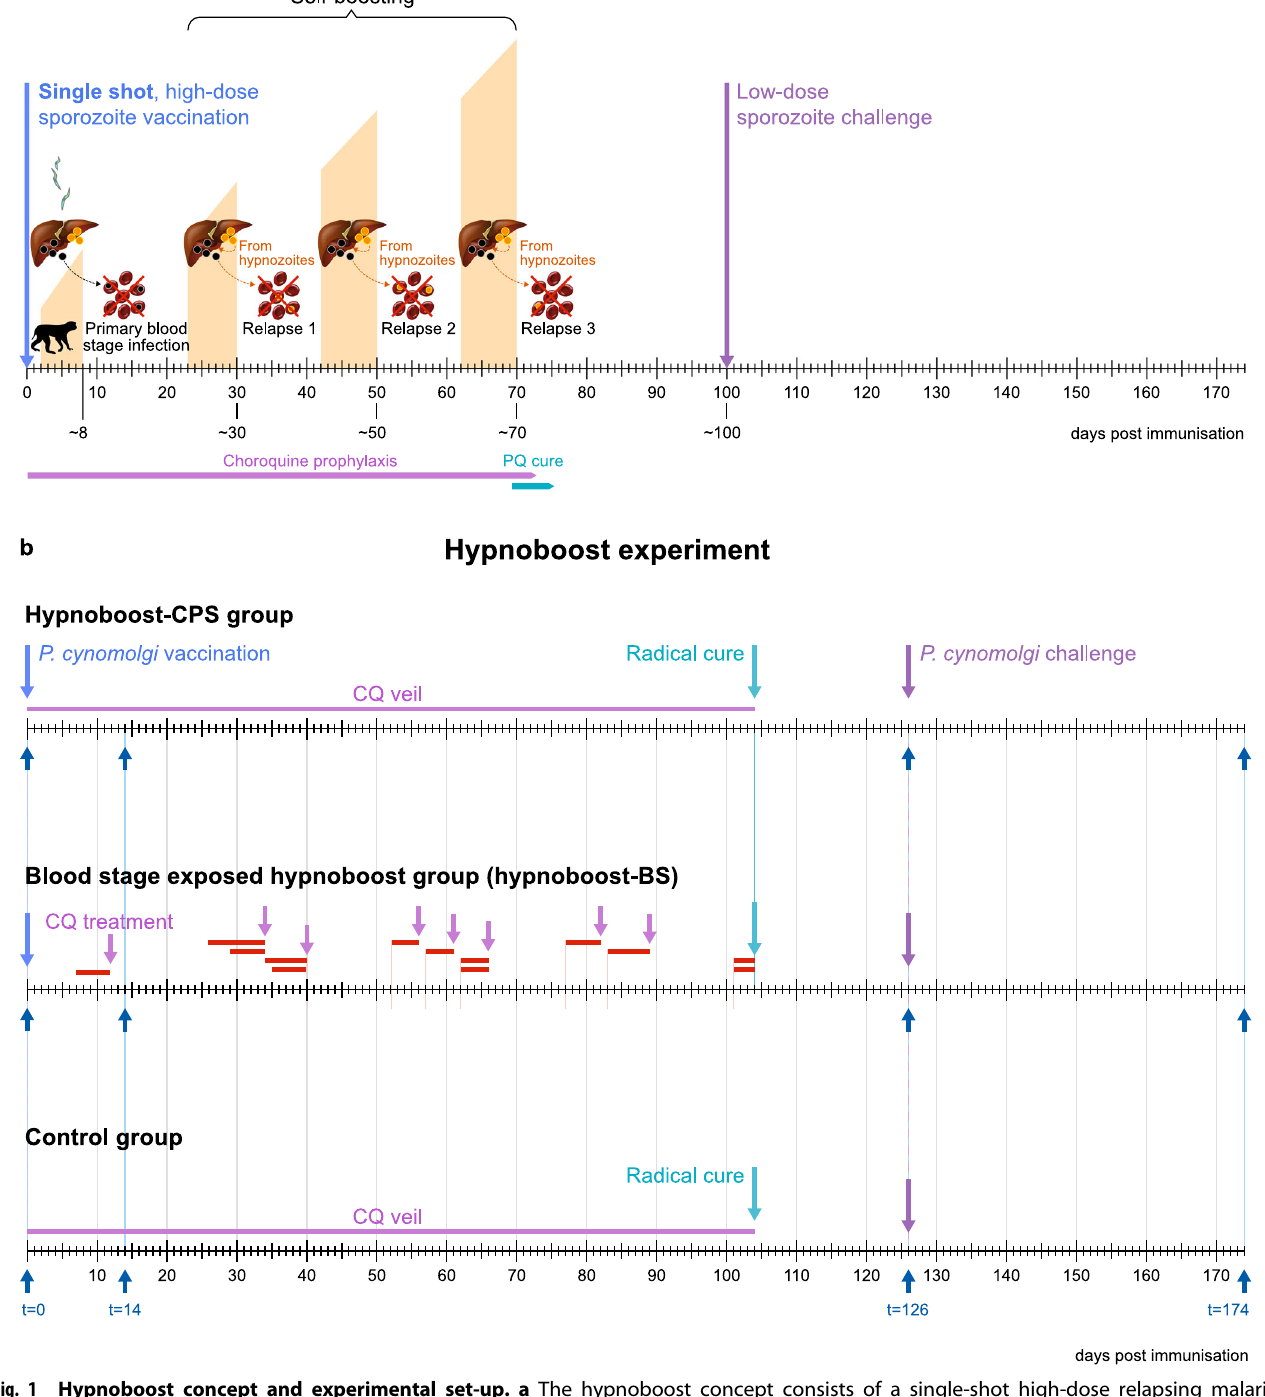
npj Vaccines (2022)